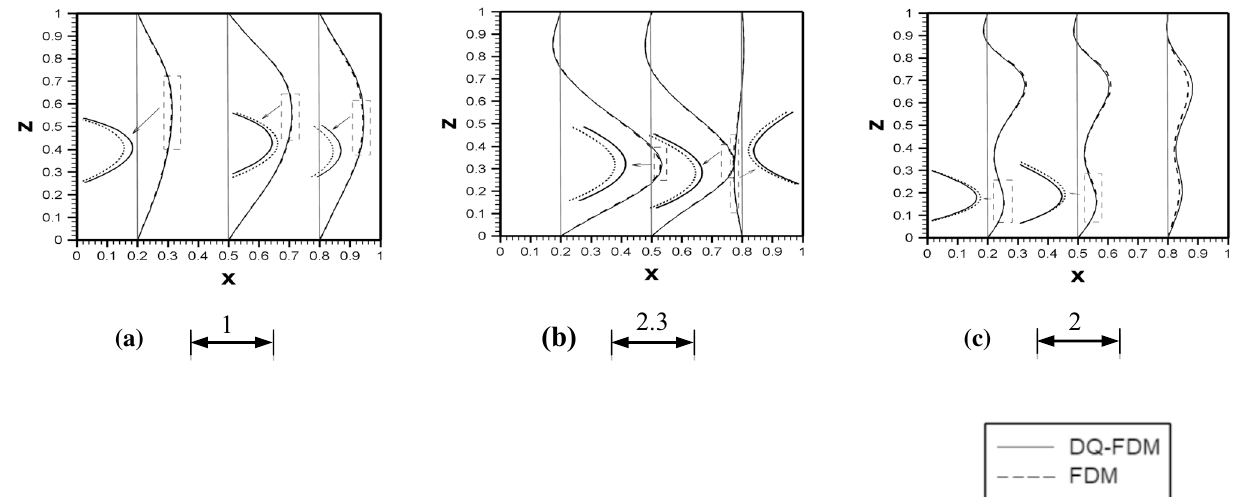
Fig. 7 A sample of comparing the distribution of the velocity of the a longitudinal ( u ), b depth ( v ) and c transverse ( w ) along the width and for passing plate through the middle of the depth (t = 0.05,